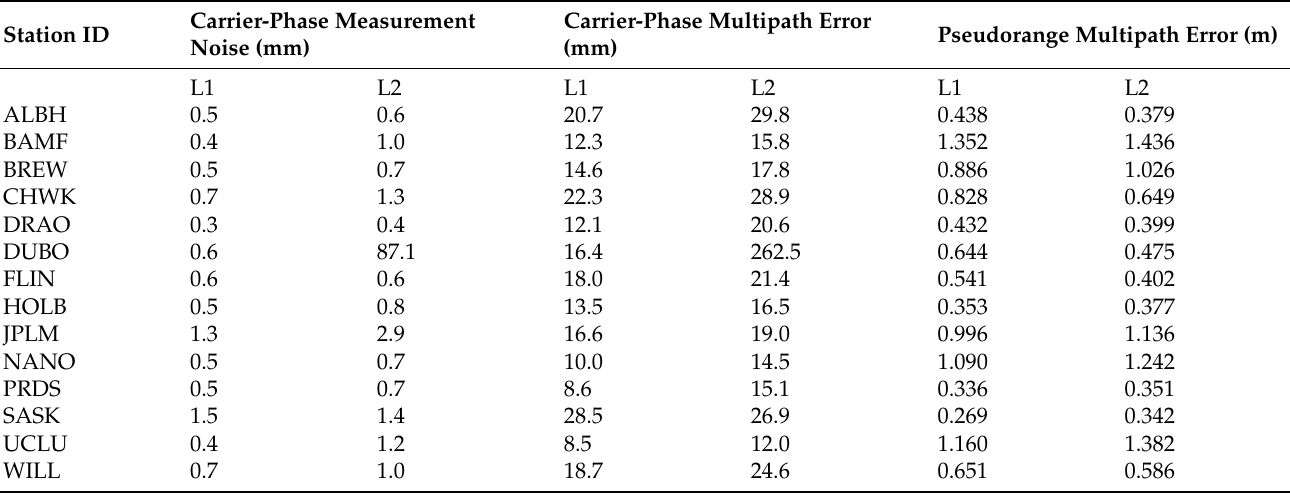
Table A18. Carrier-phase measurement noise, pseudorange, and carrier-phase multipath errors of GLONASS dual-frequency measurements of the selected IGS stations at a 95% confidence